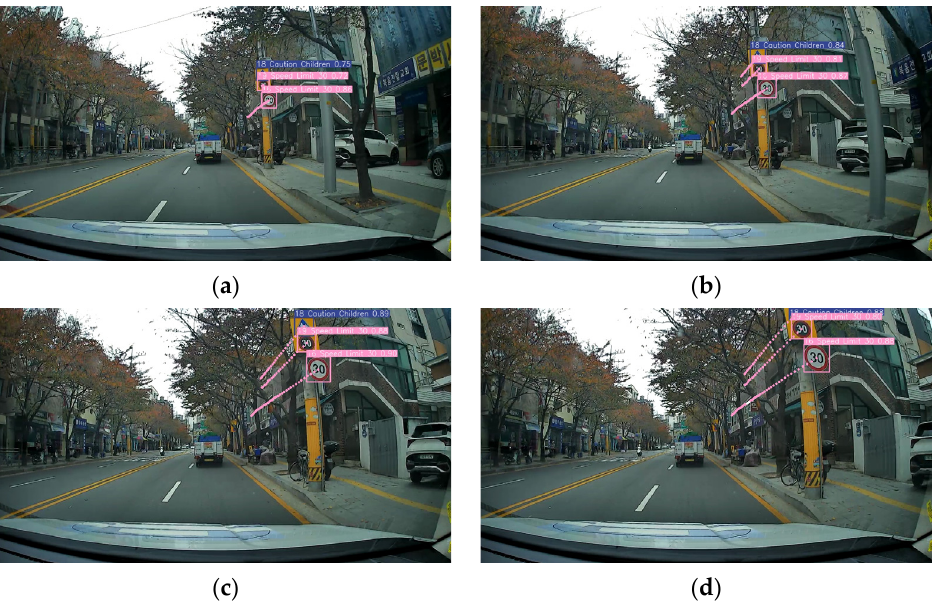
Figure 8. Examples of object tracking results applying StrongSORT coupled with YOLOv5-S. These pictures are the result of tracking traffic signs detected in consecutive frames flowing from ( a) to ( d ). Note that the dotted lines on the image represent the trajectories of the detected traffic signs.